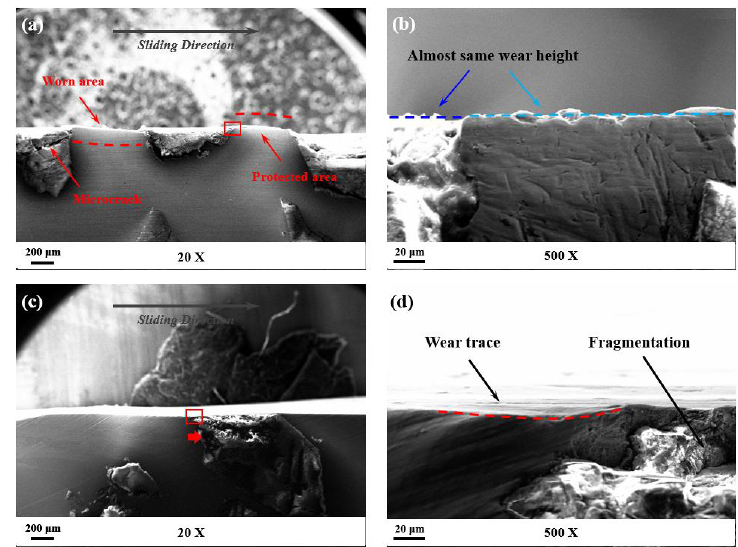
Figure 11. The worn sub-surface morphologies of the composite under different loads: ( a , b ) 300 N; ( c , d ) 900 N.